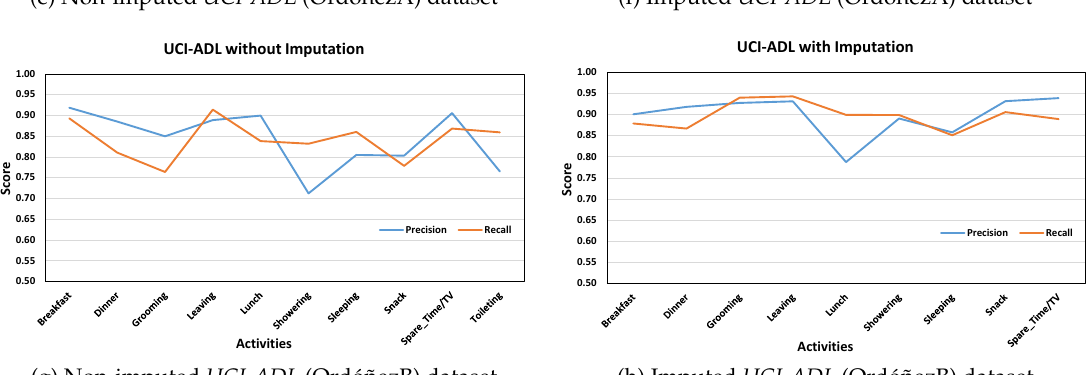
Figure 4. Classification performance of SemImput framework: Precision &